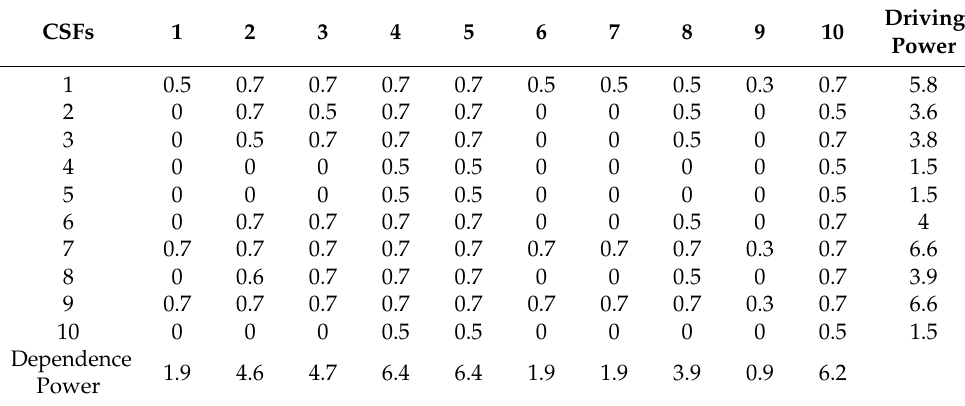
Table 7. Fuzzy stabilized matrix for determinants.